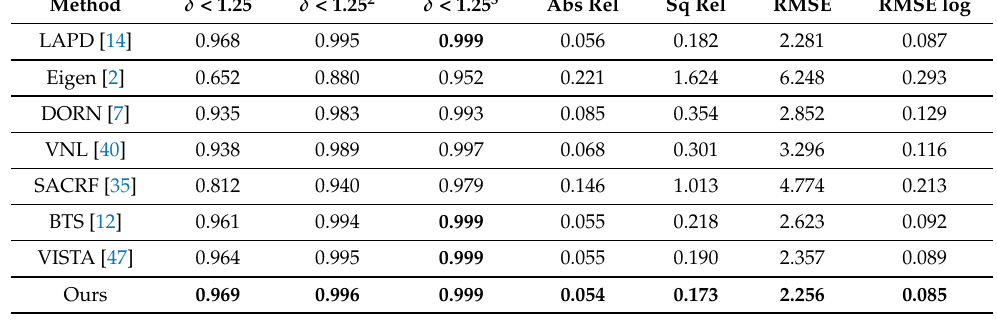
Table 4. A comparison between the selected methods on images that contained foreground regions. Method